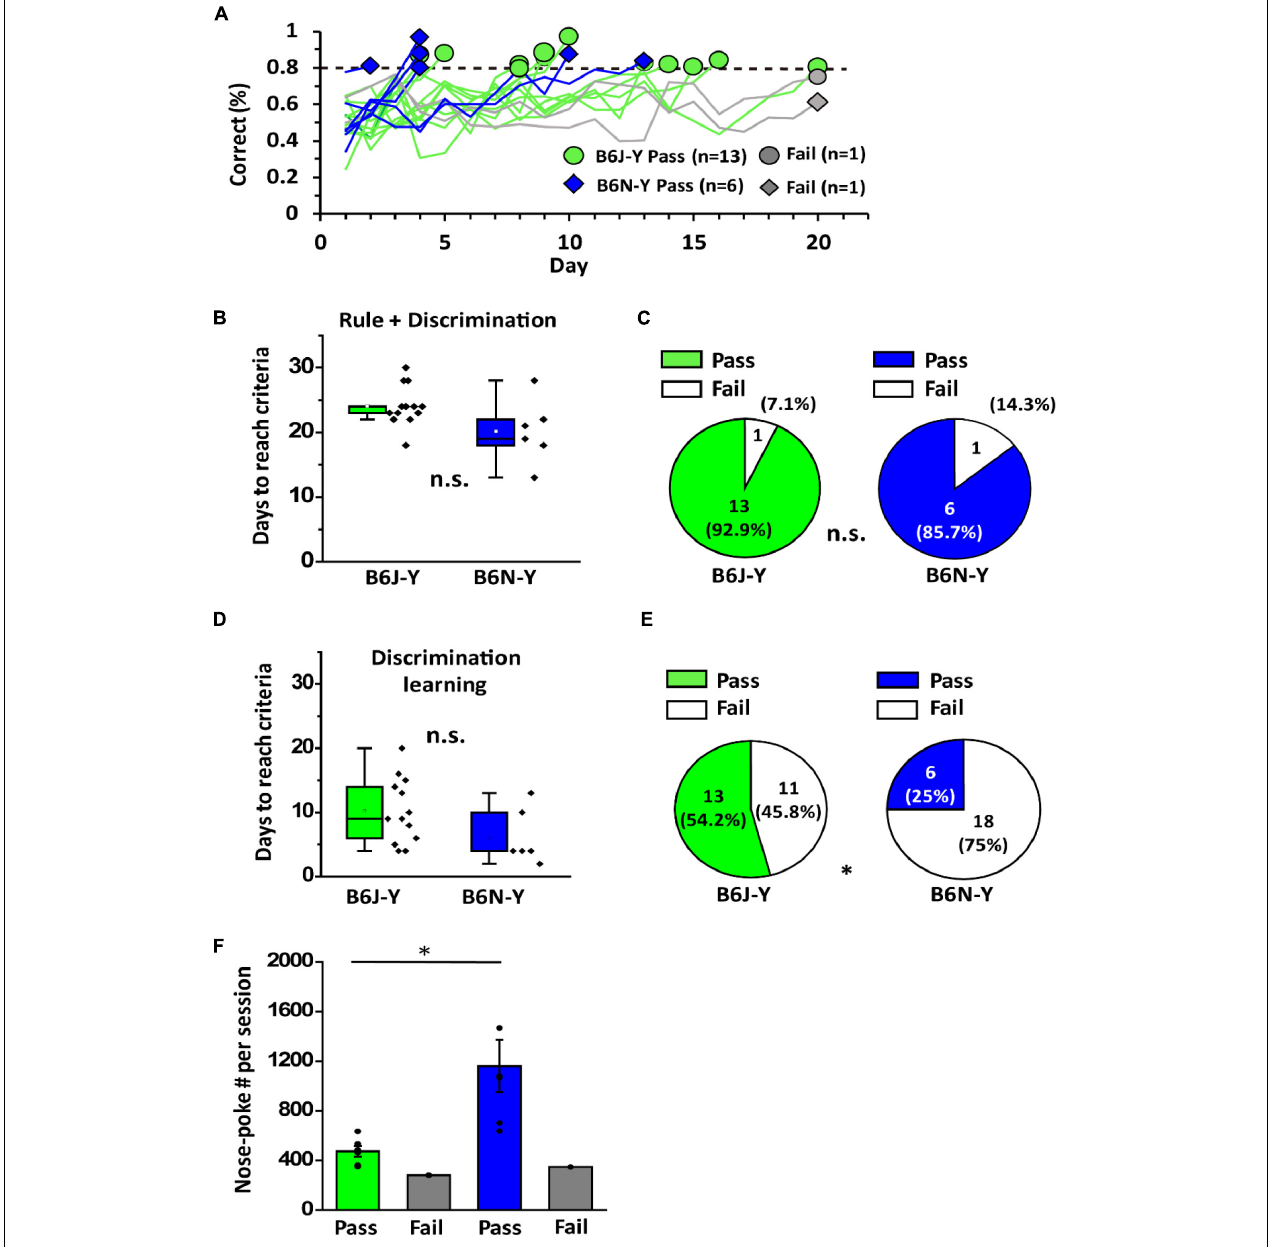
FIGURE 4 | Discrimination learning of B6J and B6N mice during young adulthood. (A) Learning curves of the B6J and B6N mice during discrimination learning. (B) Days needed for the B6J and B6N mice to reach criteria for passing discrimination learning. (C) Pass percentages of the two mice substrains in